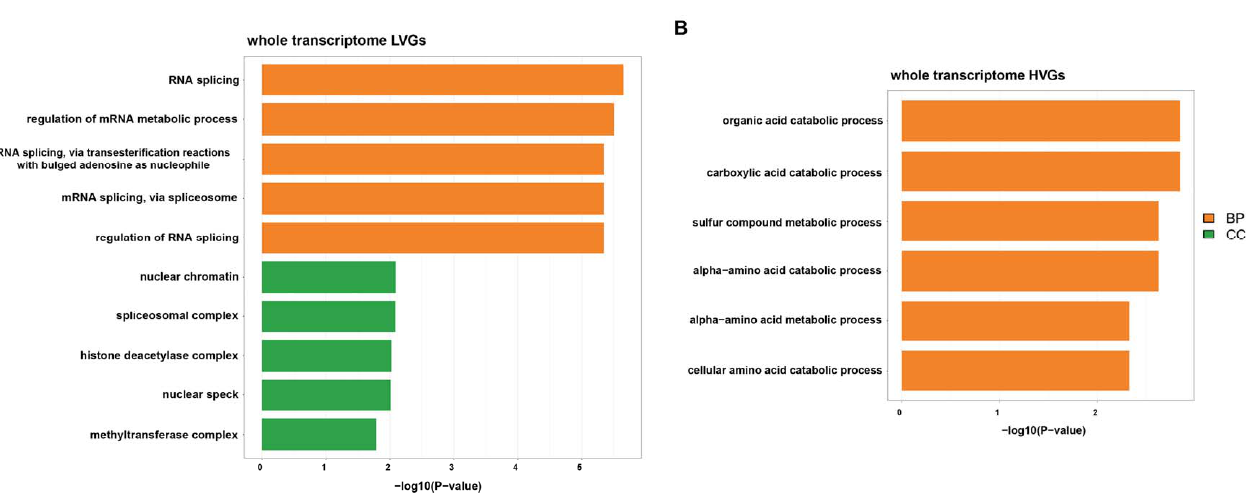
Figure 5. Functional enrichment analysis of highly variable genes (HVGs) and lowly variable genes (LVGs) across biofluid transcriptomes. The bar plots depict functional enrichment results of the top 500 HVGs ( A ) and LVGs ( B ) across the merged biofluid gene expression profiles. The colors of each bar represent different GO items, including the biological process (BP) and cellular component